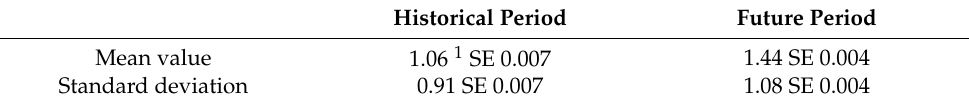
Figure 11. Standard error at different sample sizes. Table 10. Mean value and standard deviation of 2-year averaged mould index at a 2560-run.